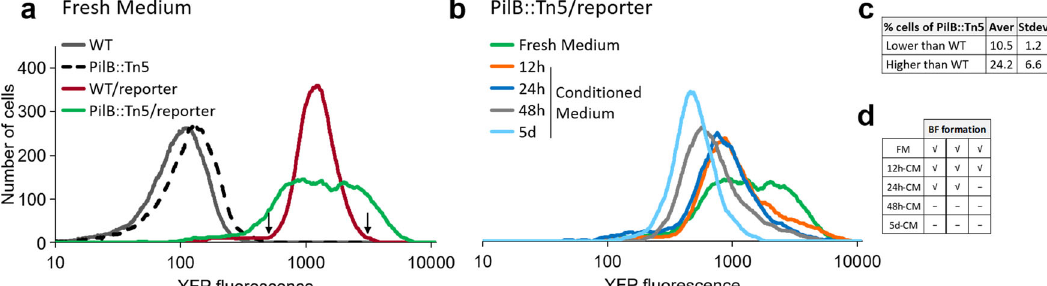
Fig. 2 Analysis of expression of the ebfG -operon by fl ow cytometry using reporter strains. a Number of cells as a function of fl uorescence in cultures grown in fresh medium (FM) for 6 days. Strains analyzed: WT, PilB::Tn5 and their cognate reporter strains that bear a fusion of the regulatory region of the ebfG -operon with a yellow fl uorescence protein (YFP). Arrows indicate fl uorescence cutoff for calculating mutant cells with lower or higher expression of ebfG -operon compared to WT. b Number of cells as a function of fl uorescence in PilB::Tn5/reporter cells grown in FM and conditioned medium (CM). c Fraction of PilB::Tn5/reporter cells with lower or higher expression of ebfG -operon compared to WT/reporter. Shown are averages and standard deviations from three independent experiments. d Bio fi lm (BF) formation by PilB::Tn5/reporter cells grown in FM or CM harvested at different time points of WT